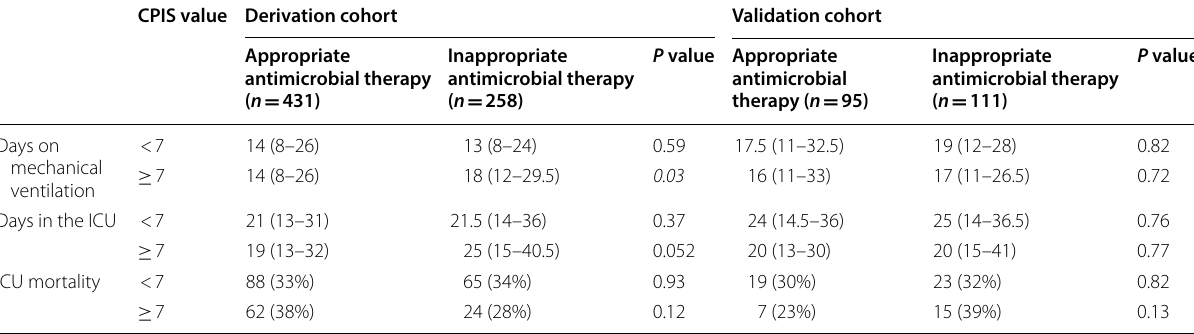
Data are presented as number (%) or median (interquartile range) ICU Intensive care unit; CPIS Clinical pulmonary infection score p values < 0.05 are indicated in italic